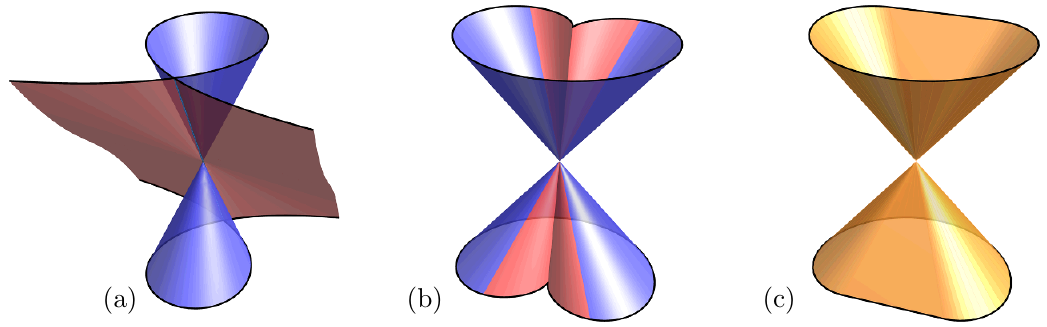
Figure 3 . The normal cone (a), the ray cone (b), and the causal cone (c) for a peculiar hyperbolic PDE of third order. The reciprocal sheets of the normal and the ray cone are depicted in the same color. See appendix A for further